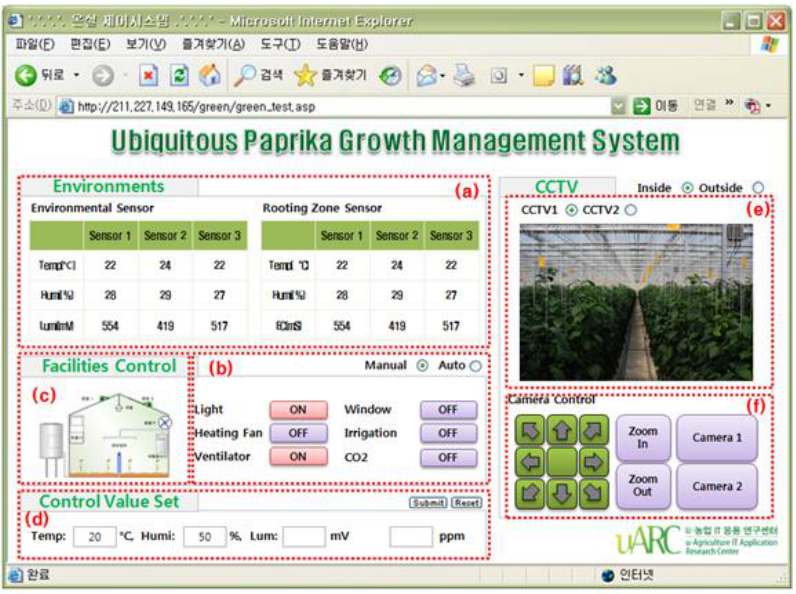
Figure 14. Ubiquitous Paprika Growth Management System